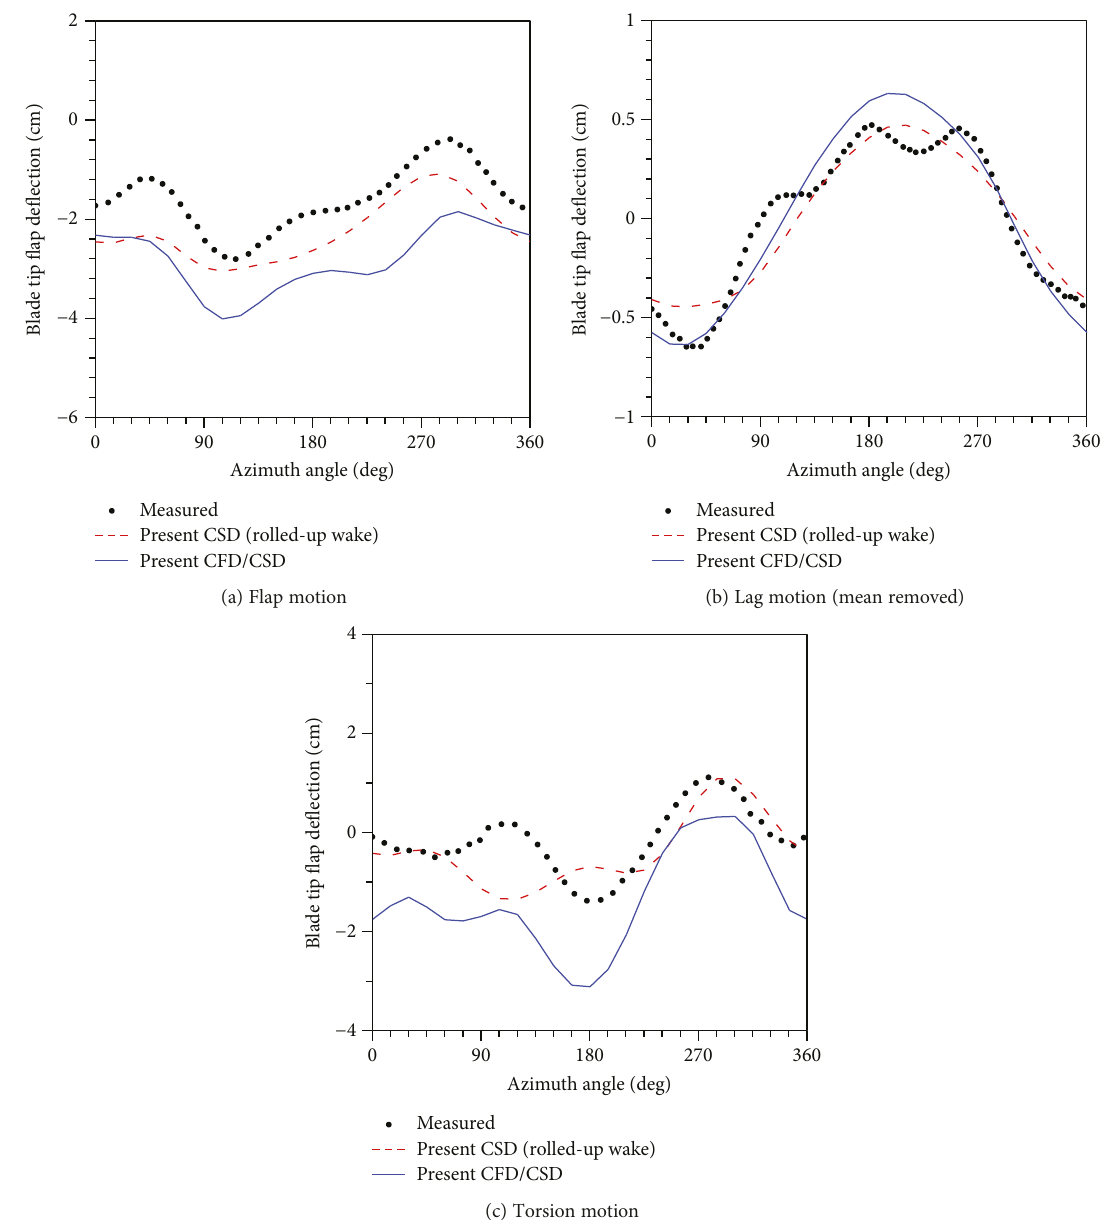
Figure 16: Correlation of blade tip elastic de fl